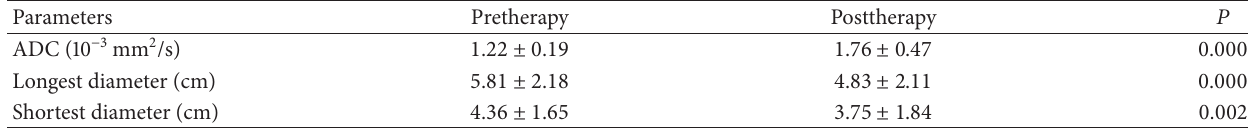
Table 2: Comparison of ADC values and different diameters before and after